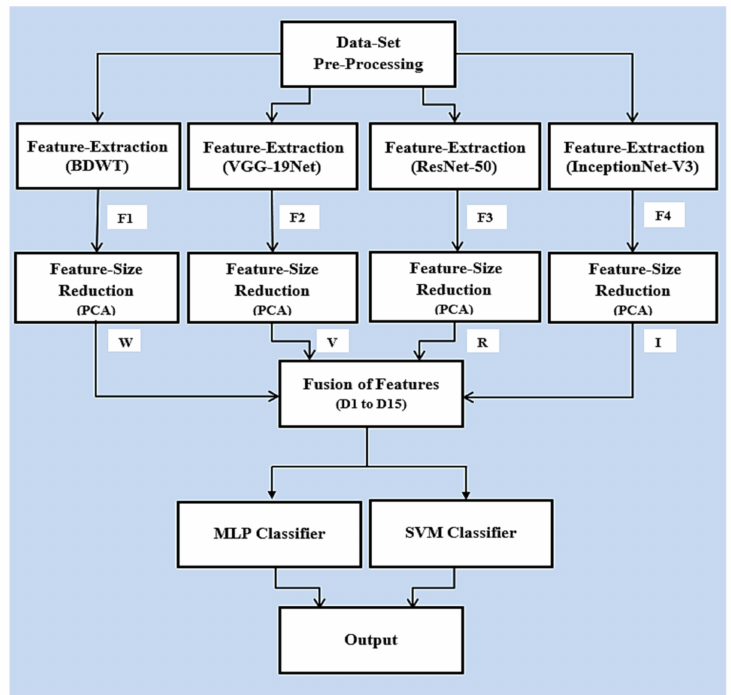
Figure 3. Design of the proposed work.